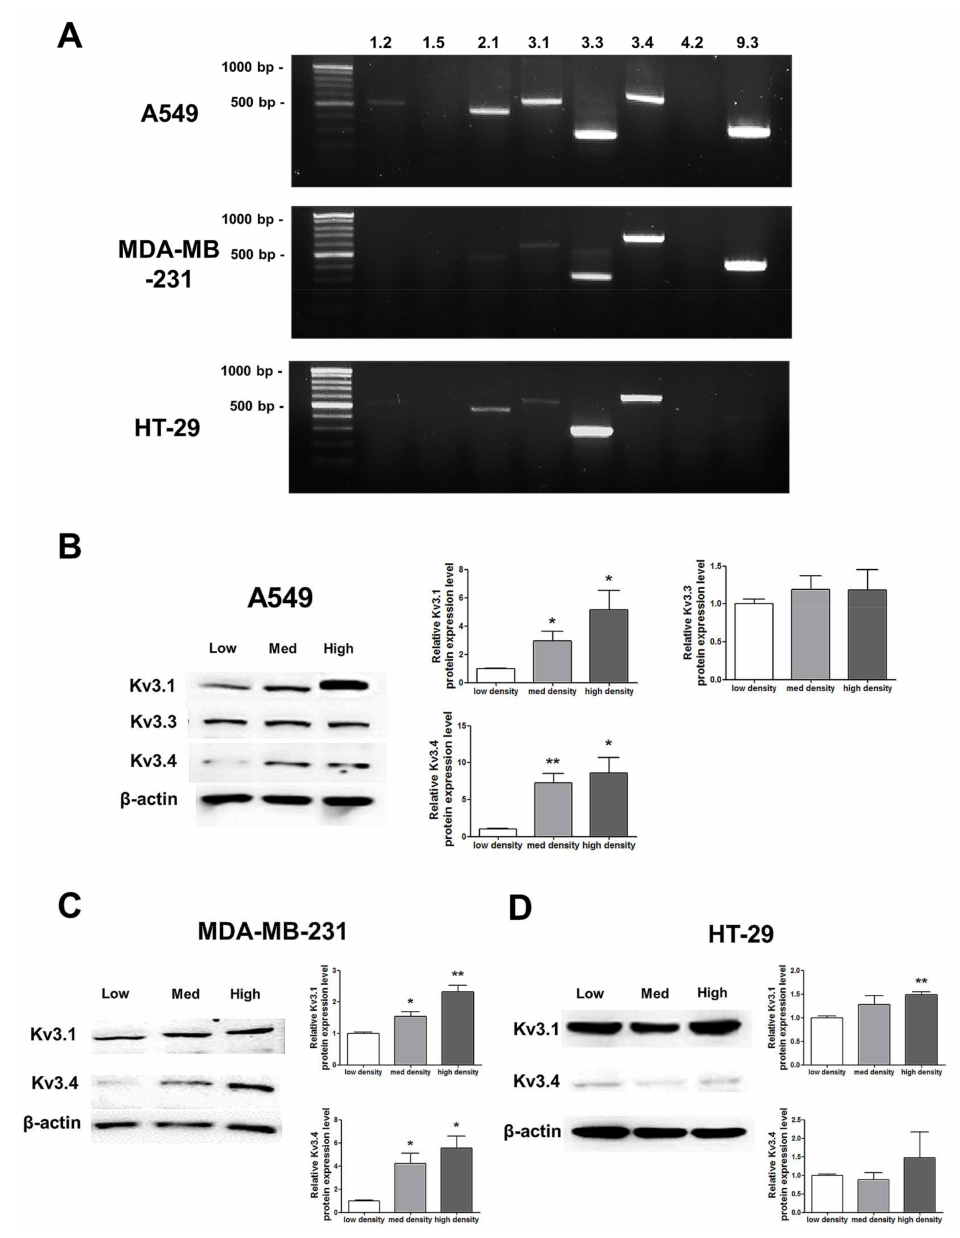
Figure 3. Changes in mRNA and protein expression of Kv3.1, Kv3.3, and Kv3.4 according to cell density. ( A ) RT-PCR data demonstrating that Kv3.1, Kv3.3, and Kv3.4 mRNA was expressed in A549, MDA-MB-231, and HT-29 cells. ( B ) The protein expression levels of Kv3.1, Kv3.3, and Kv3.4 were analyzed by Western blot. Kv3.1 and Kv3.4 were increased in A549 cells dependent on the cell density, whereas Kv3.3 was not altered according to the cell density. ( C , D ) Kv3.1 and Kv3.4 protein expression levels were analyzed in MDA-MB-231 and HT-29 cells by Western blot. Kv3.1 and Kv3.4 were increased in MDA-MB-231 cells according to the increase in cell density. Only Kv3.1 was significantly increased in high-density HT-29 cells compared to that in low-density HT-29 cells. Kv3.4 expression was not significantly increased in HT-29 cells as the cell density increased. All experiments were performed in triplicate, and the data represent the mean ± standard error. * p < 0.05 and ** p < 0.01 versus the low-density